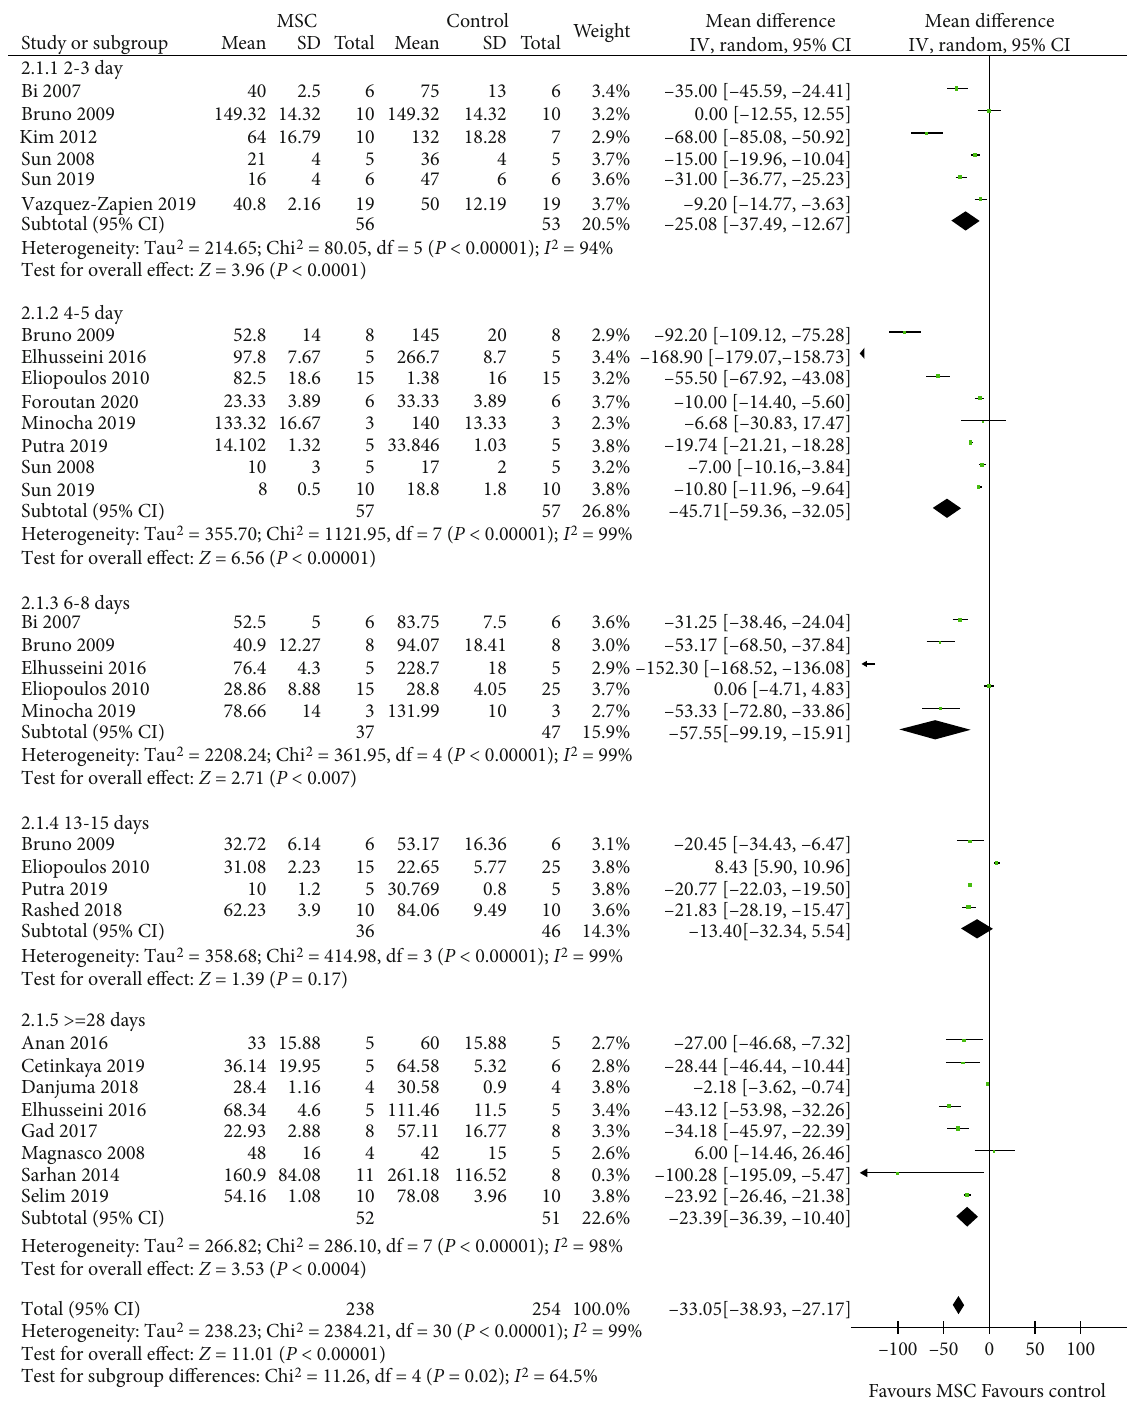
Figure 4: E ff ect of MSC on